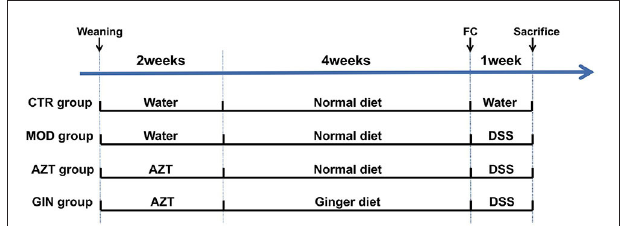
TABLE 1 | Composition of experimental diets (g).